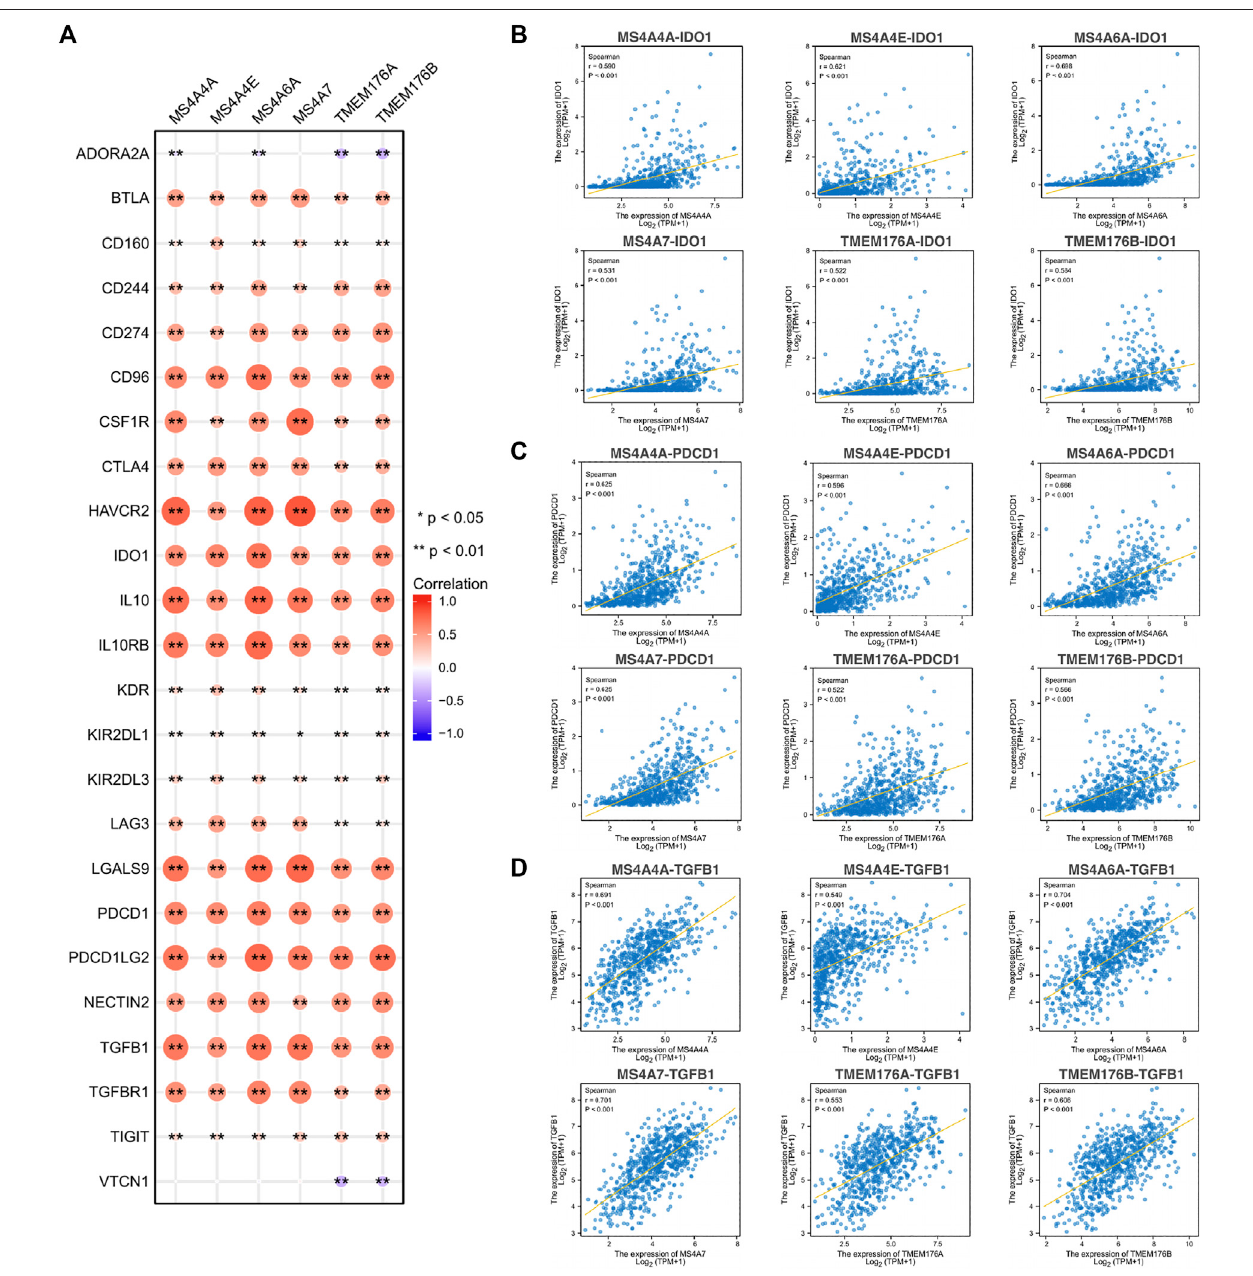
FIGURE10| CorrelationsbetweenMS4Asandimmune inhibitorymolecules. (A) MS4Aexpressionishighlycorrelatedwithimmuneinhibitorymoleculesinglioma. Thecolorand sizeofthecirclesrepresent theR-value ofSpearman ’ scorrelation. (B – D) Scatterplots showingthestrong associationofMS4Alevelswith IDO1 , PDCD1 , and TGFB1 . Correlation coef fi cients were classi fi ed as weak (0.1 ≤ r < 0.3), moderate (0.3 ≤ r < 0.5), or strong ( r ≥